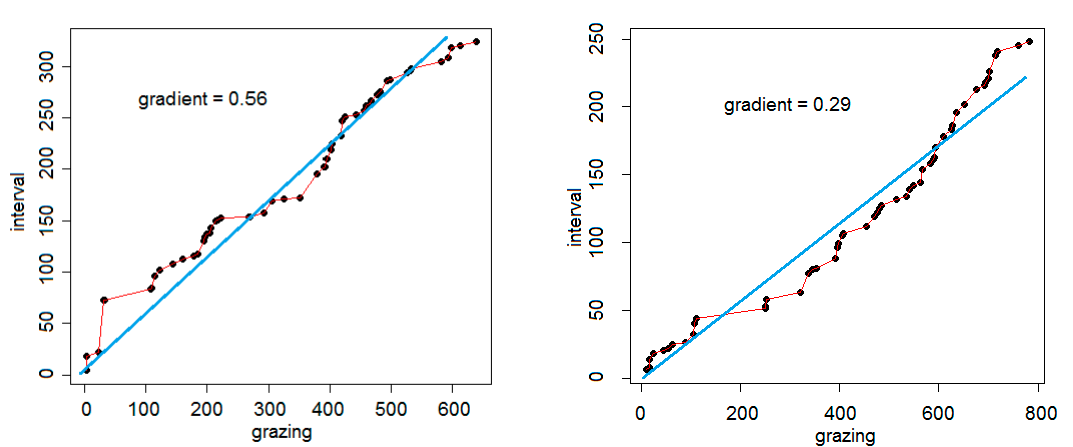
Figure 1. Grazing-interval trajectories for two specimen watches. For each, the cumulation, in seconds, of grazing bouts ( x -axis) is plotted against that of interval bouts ( y -axis). Total durations were 962 s (left-hand plot; 638 s grazing and 324 s interval) and 1030 s (right-hand plot; 782 s grazing and 248 s interval). The line of best fit, forced through the origin, is given with its gradient.